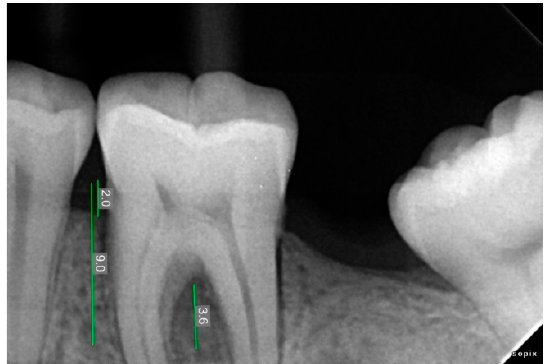
Figure 4. Three Month Post-Operative Radiograph of 36 treated with AM + NB .